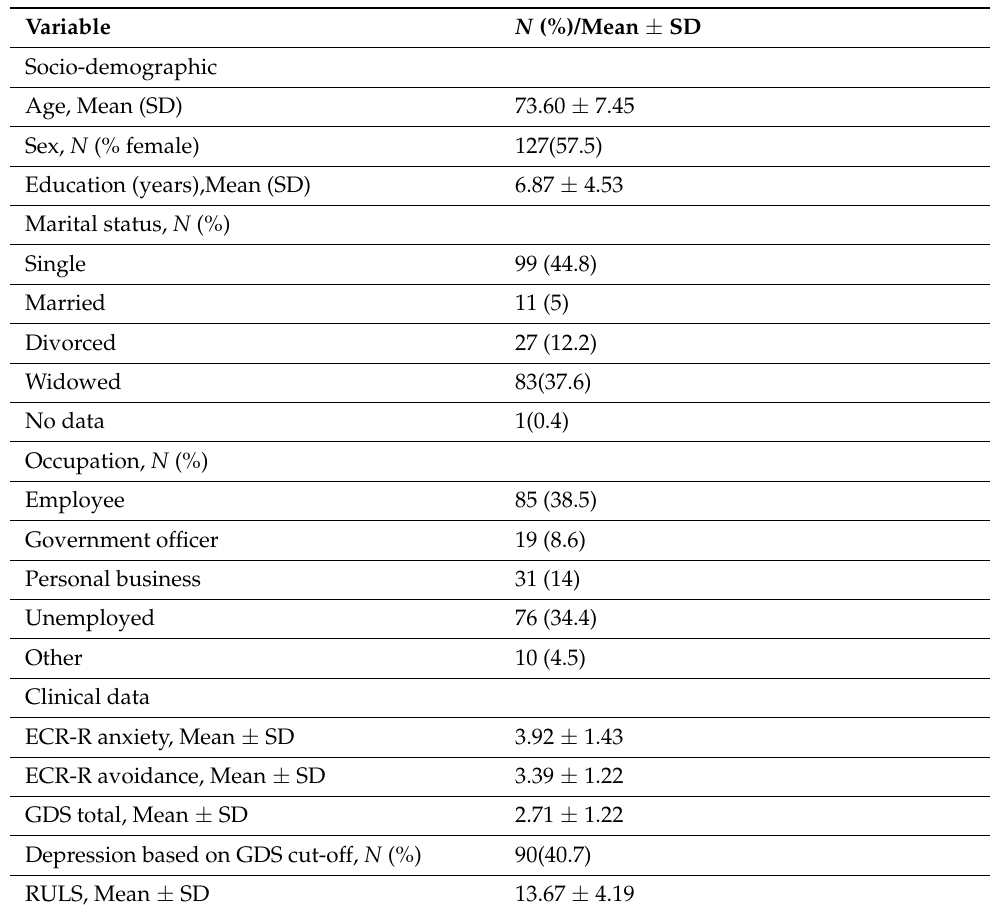
Table 1. Participants’ characteristics ( N = 221).